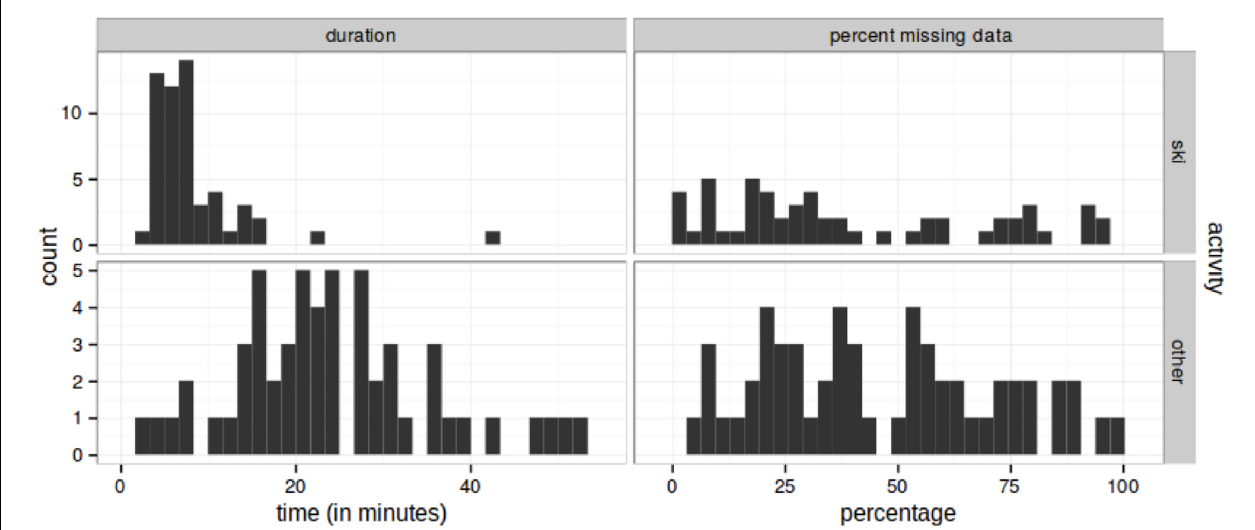
FIGURE 2 | Total duration (in minutes, left column) and missing data (in percent, right column) of skiing (top row) and ski-breaks (bottom row). Written informed consent has been obtained from the participant for the publication of this image.